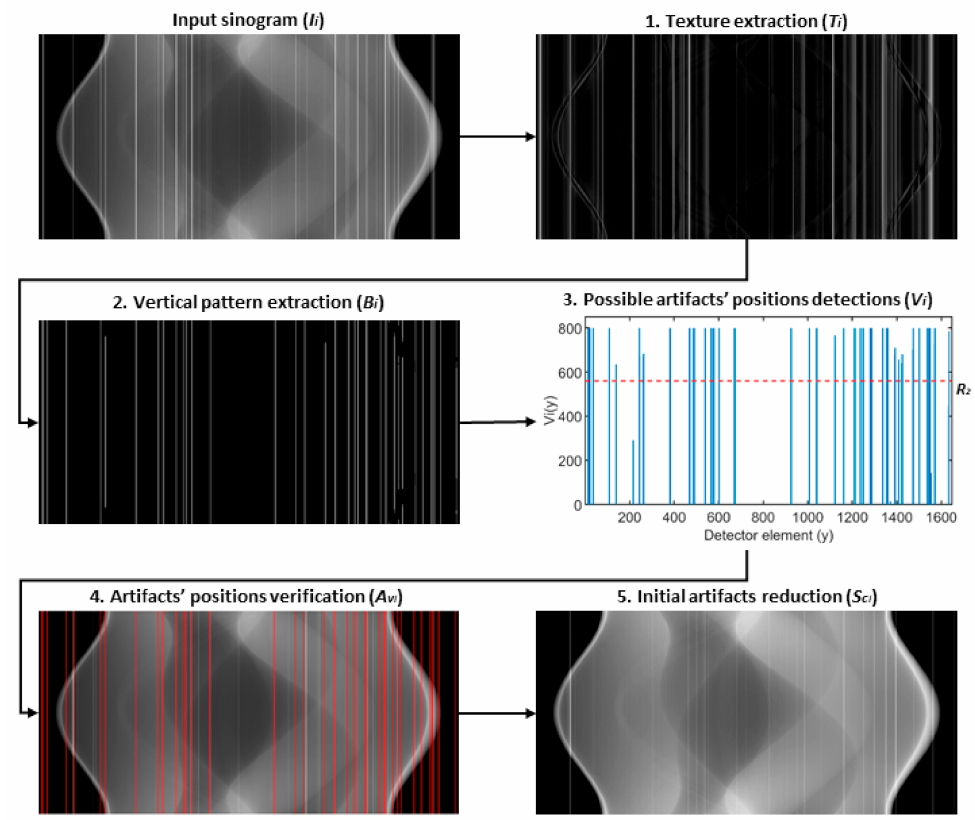
Figure 2. Illustrative scheme of proposed high-level ring artifacts detection scheme—as example images, the outputs from the first iteration are